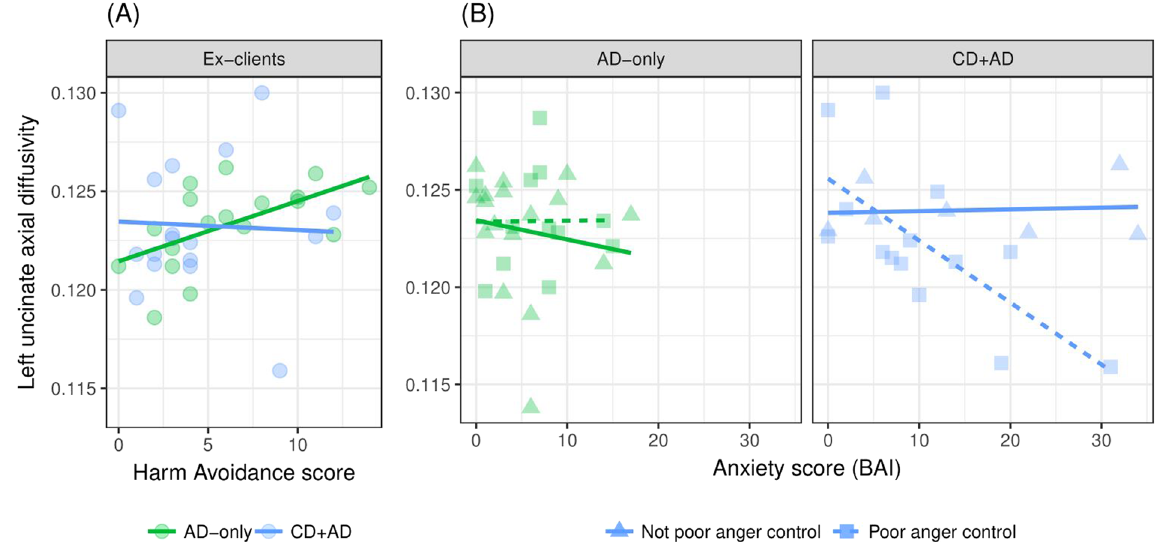
Figure 3. Disorder-distinct association of uncinate integrity with Harm Avoidance traits and the interaction of anger control ability and anxiety. ( A ) A significant correlation between Harm Avoidance traits (measured in adolescence) in ex-clients with AD-only, but not CD + AD. ( B ) A significant interaction effect of poor anger control and anxiety scores in participants with CD + AD (right panel) but not AD-only (left